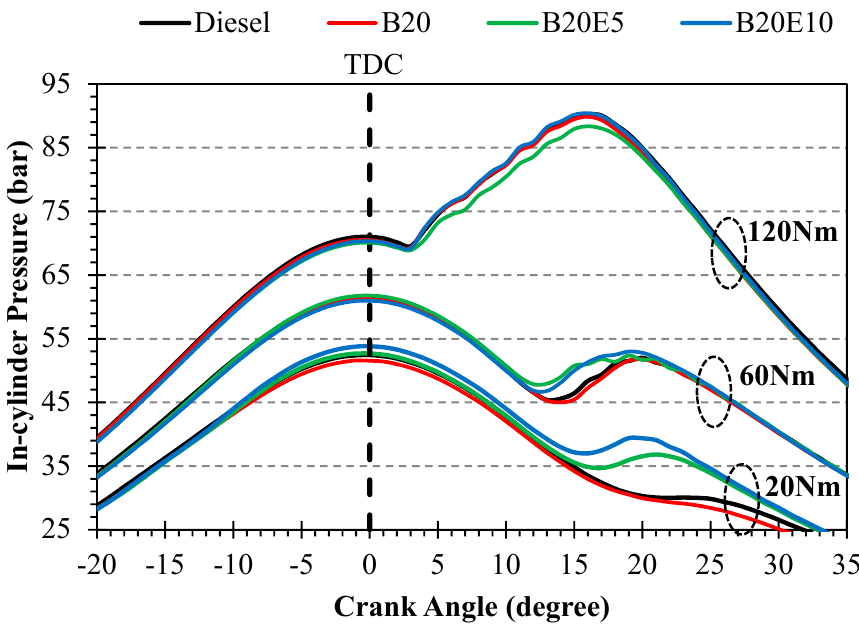
Figure 7. The variation in combustion pressure for diesel, B20 and B20E5 at an engine load of 20 Nm, 60 Nm, and 120 Nm.